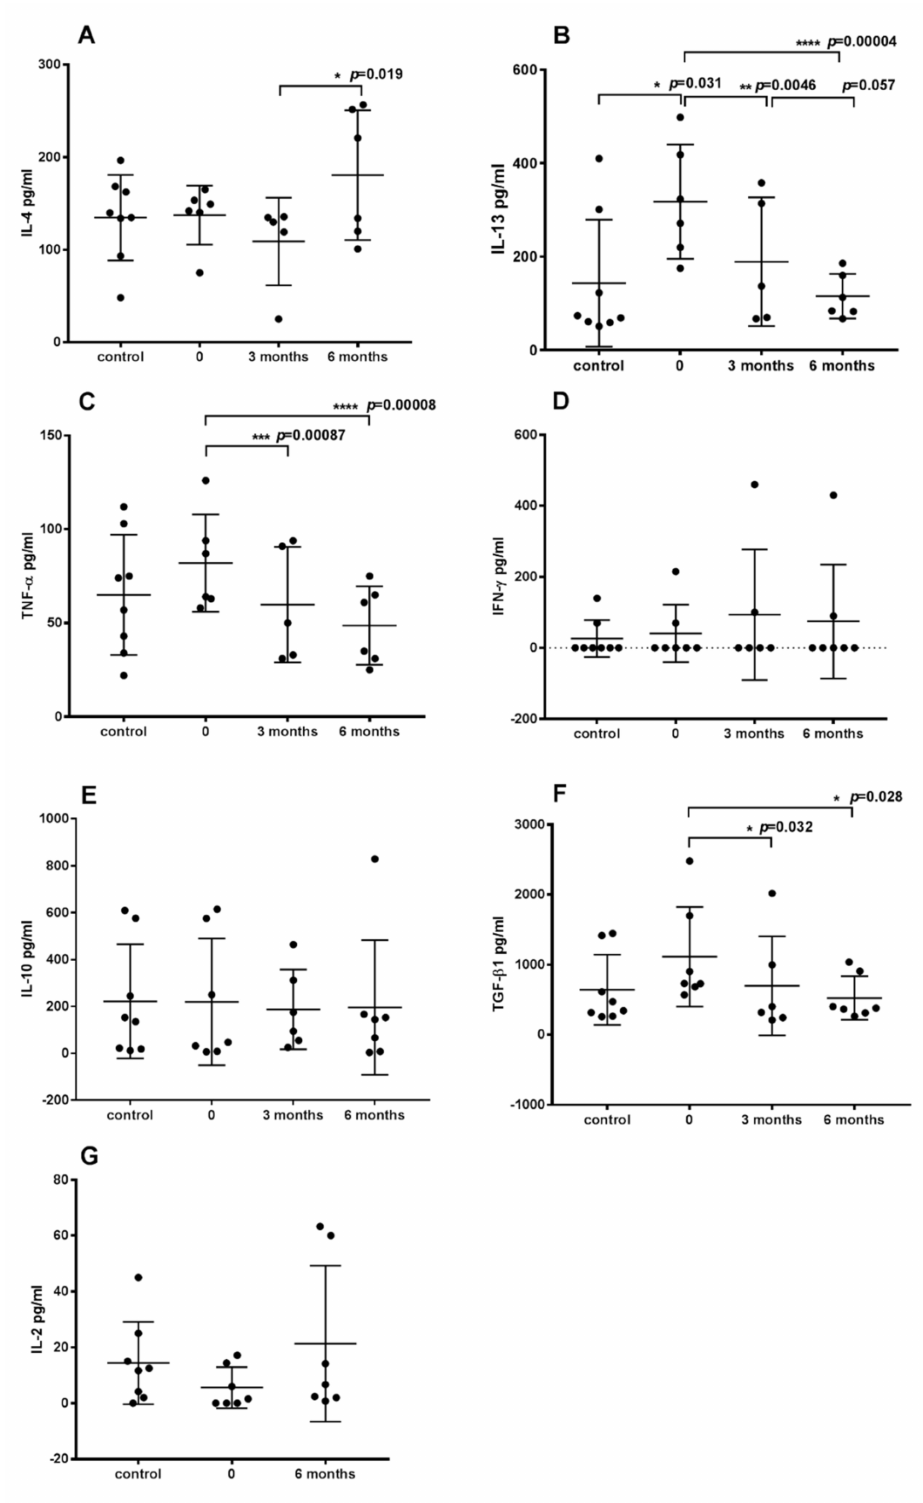
Figure 4. Concentration of cytokines ( A ) IL-13, ( B ) IL-4, ( C ) TNF- α , ( D ) IFN- γ , ( E ) IL-10, ( F ) TGF β 1 and ( G ) IL-2 in plasma of dogs with atopic dermatitis before ASIT (0), after 3 and 6 months of therapy, and in healthy dogs (control). All data represent the mean ± standard deviation. Symbols: *, **, ***, **** represent the level of significance, respectively: p < 0.05, p < 0.01, p <0.001, p < 0.0001 (repeated measures ANOVA with Fisher’s post-hoc